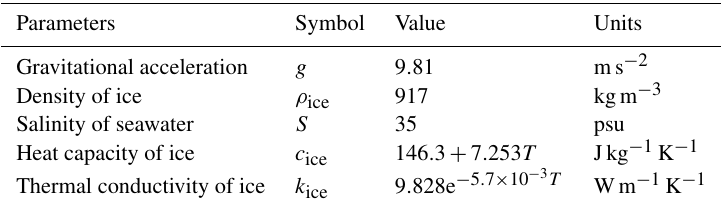
Table 2. Standard physical parameters of the 1-D temperature column simulation. The heat capacity, c ice , and thermal conductivity, k ice , are functions of temperature, T , in K (Ritz,